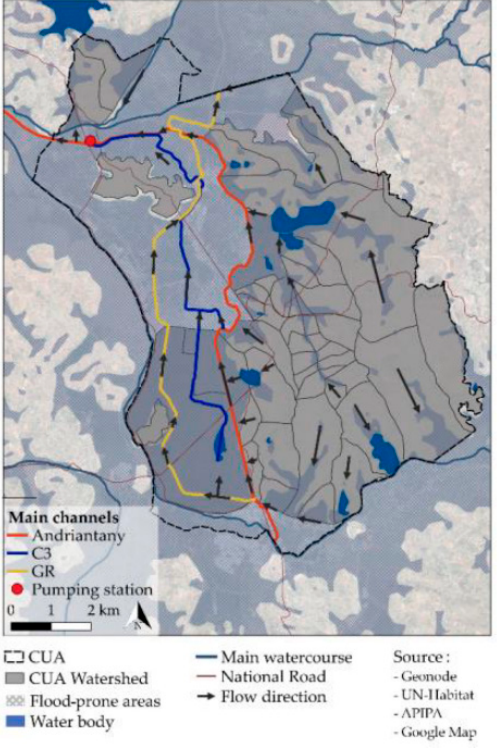
Figure 5. Urban Community of Antananarivo (CUA) watershed.